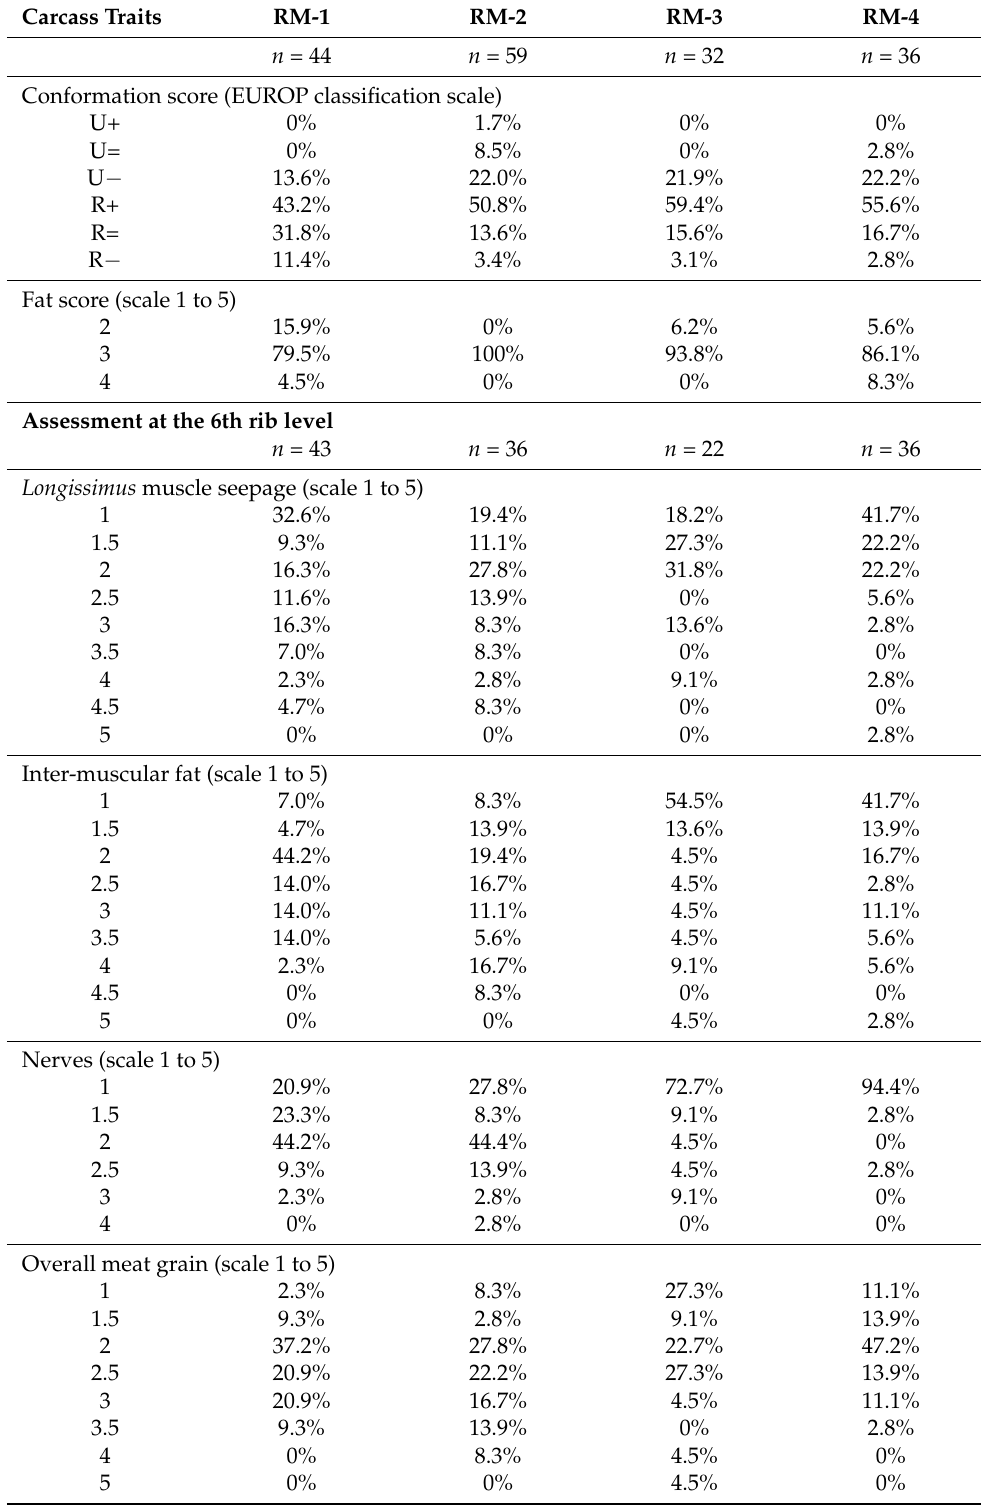
Table A1. Distribution of the carcasses according to the scale of carcass traits and the rearing management